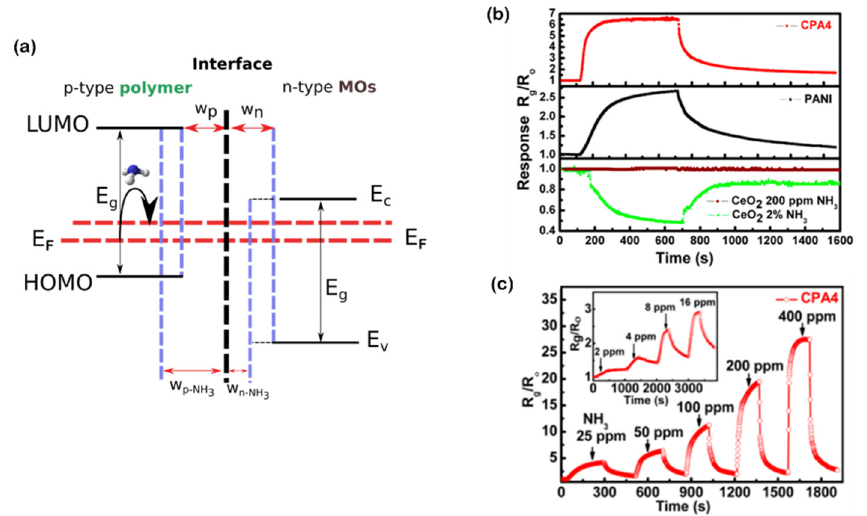
Figure 14. ( a ) Schematic energy diagram of the p-n junction between a p-type polymer and an n-type MO at equilibrium, when exposed to a reductor gas, such as NH 3 . Adapted and modified from [56] and ( b ) typical response curves of composite containing CeO 2 and PANI (labelled as CPA4), pristine PANI and CeO 2 nanoparticles at RT exposed to 50 ppm of NH 3 . ( c ) The response of the composite at different concentrations. Reproduced with permission from [56]. Copyright by American Chemistry Society (2014).